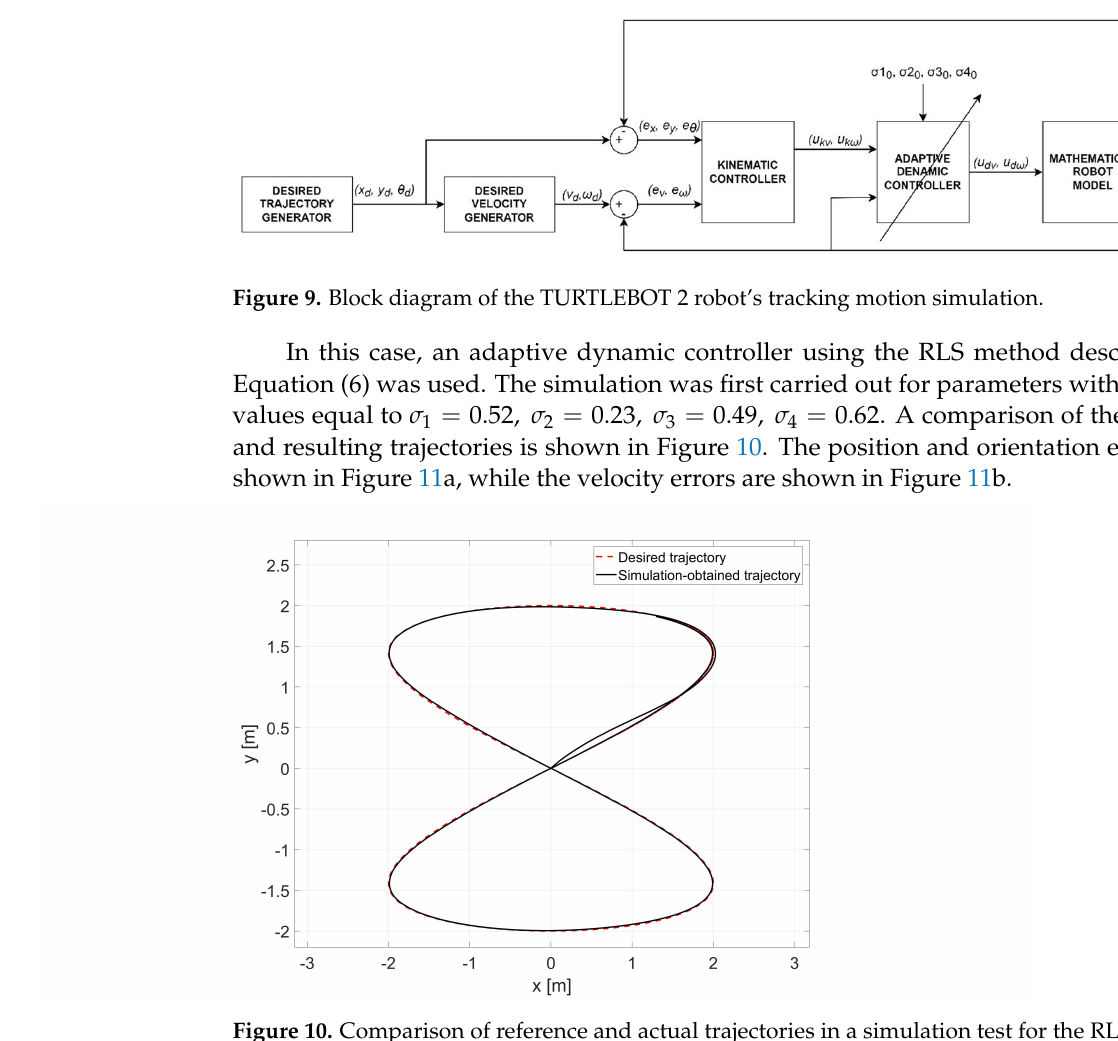
Figure 10. Comparison of reference and actual trajectories in a simulation test for the RLS method with random initial parameters.